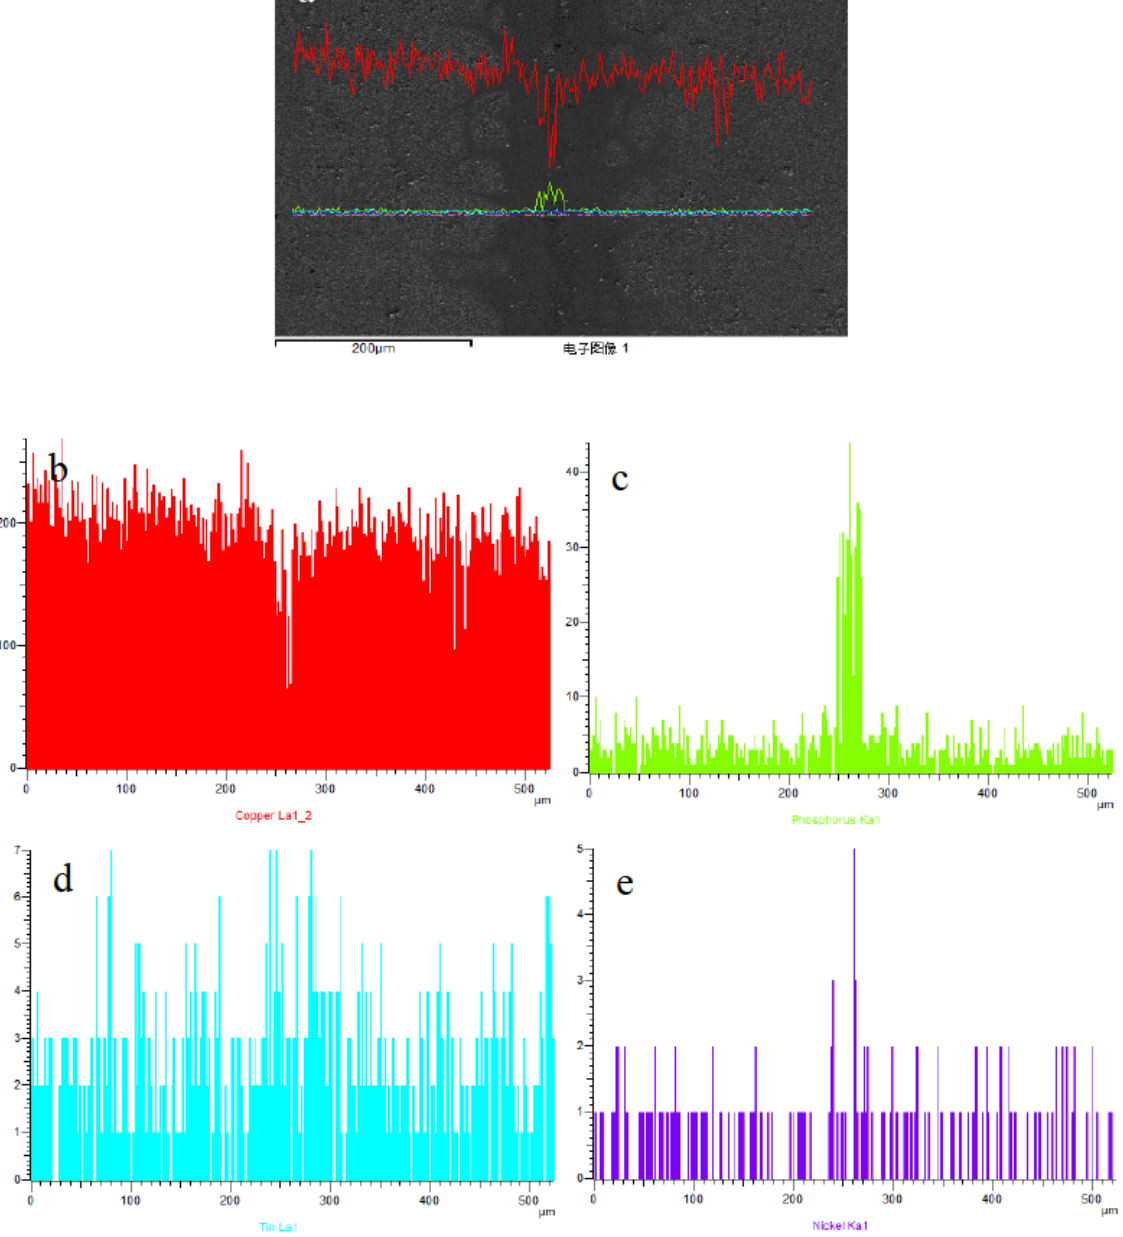
Figure 12: Energy-dispersive spectra elemental line scan results of the brazing joint of the amorphous filler metal at 660 ∘ C, showing the (a) line scan position on the micrograph, and the distribution of the (b) Cu, (c) P, (d) Sn and (e) Ni elements along the line